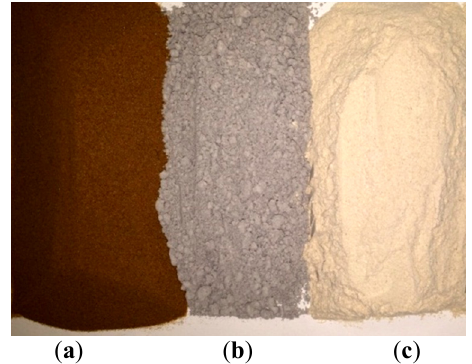
Figure 5. Different types of additives: dune dust additive (DDA) ( a ), fly ash additive (FAA) ( b ) and quarry dust additive (QDA) ( c ).